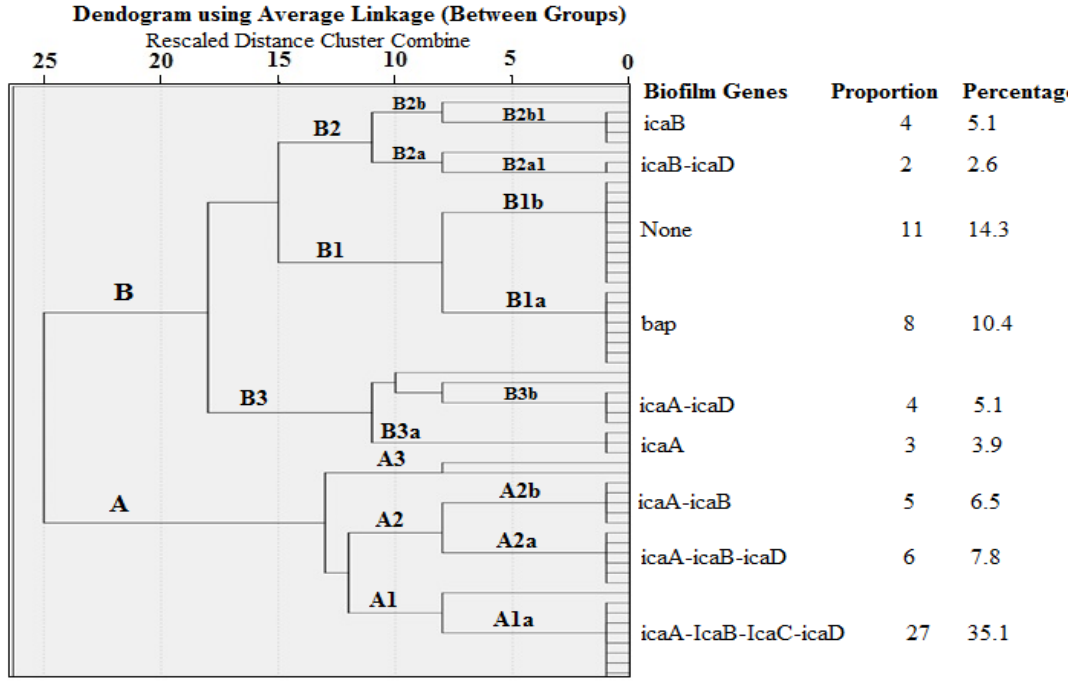
Figure 2. A dendrogram showing the clustering of biofilm genes based on OD 680 of S. aureus isolates (the dendrogram was obtained by using the unweighted paired group method).